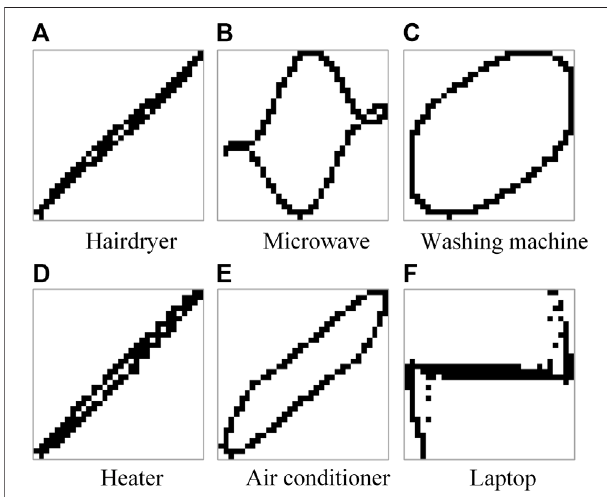
FIGURE 2 | Image of the V - I trajectory